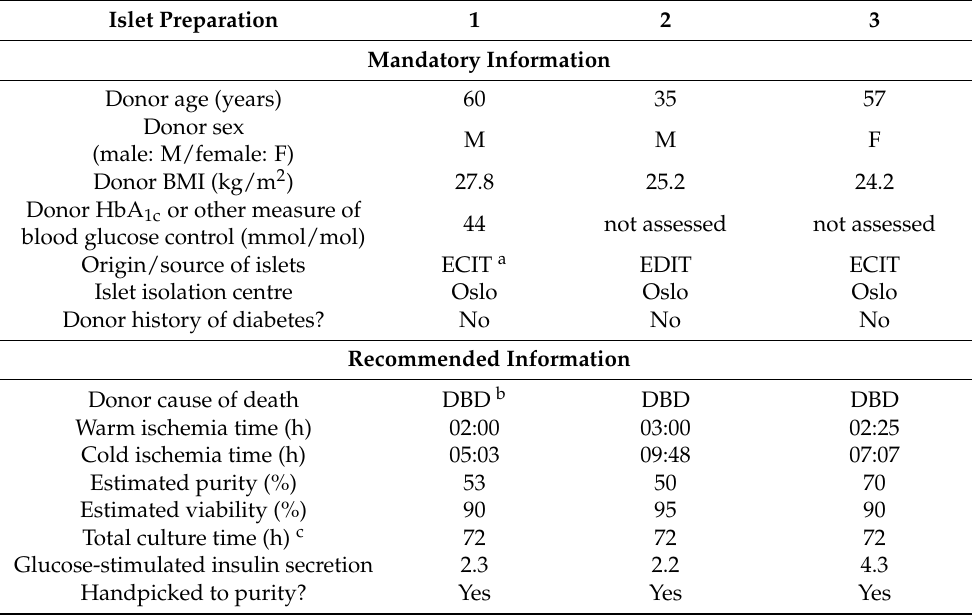
Table 1. Checklist for reporting human islet preparations used in research. Table format adapted from (Hart and Powers,